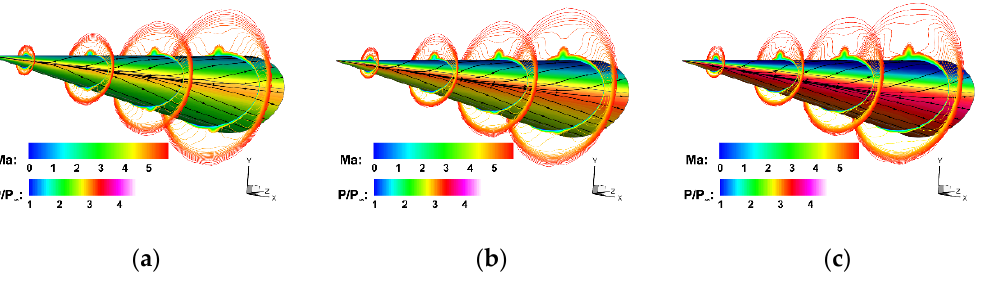
Figure 15. Azimuth diagram of HIFiRE-5.